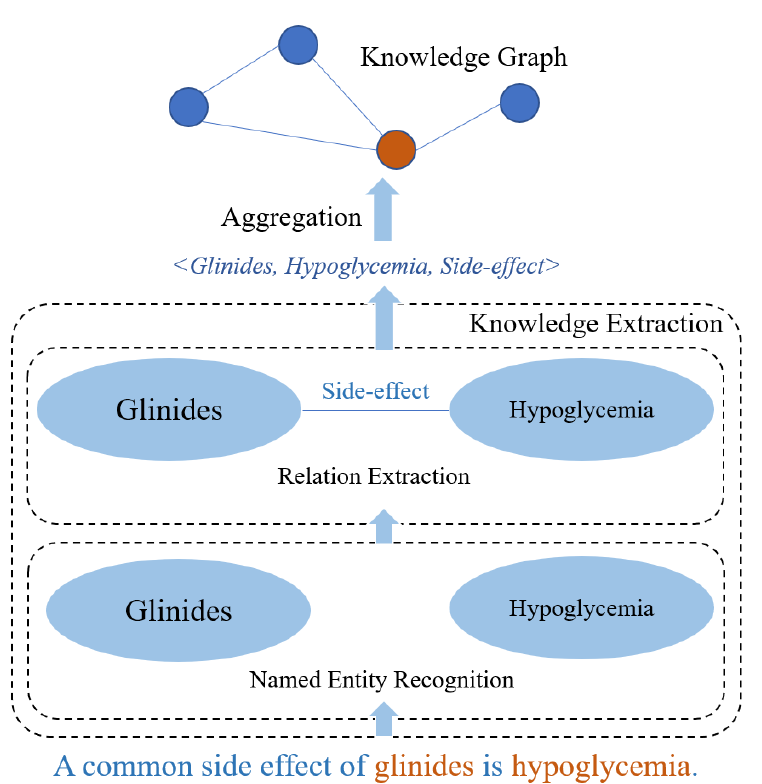
Figure 1. The standard knowledge extraction method adapted for unstructured